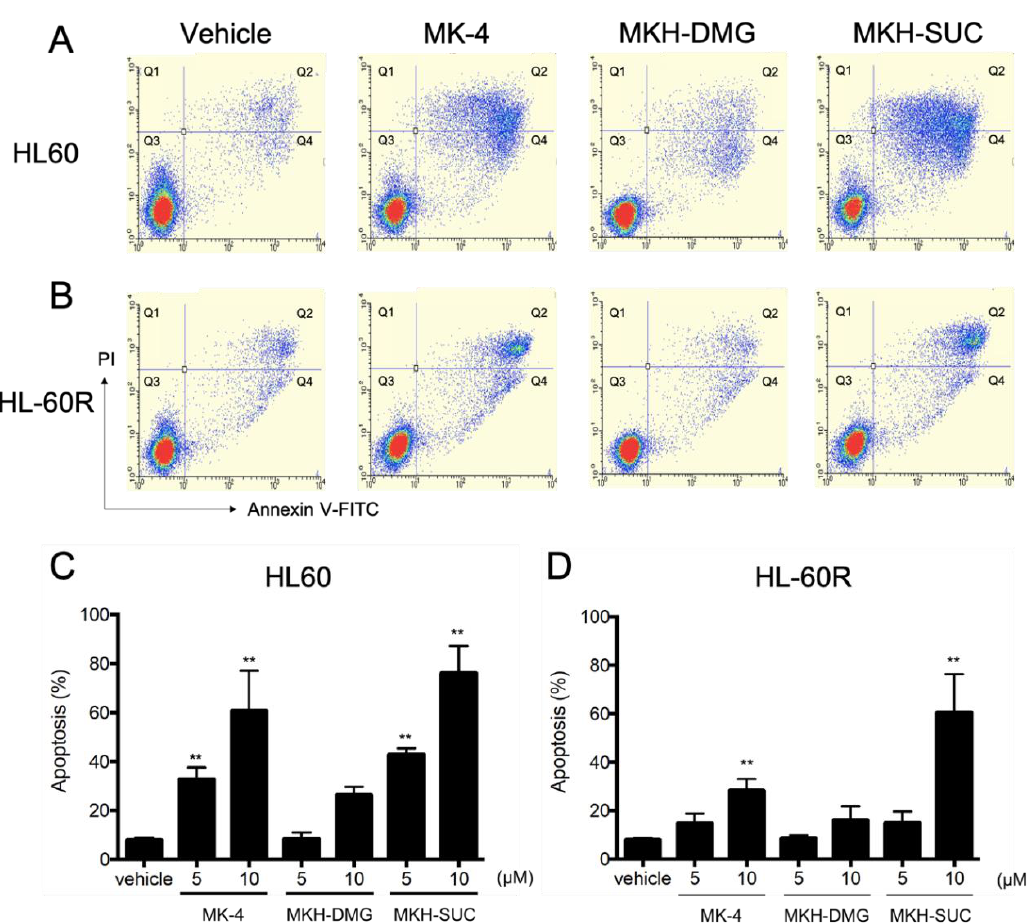
Figure 6. Effects of MK-4 and MKH derivatives on the apoptosis in HL60 and HL-60R cells. Typical flow cytograms of HL60 ( A ) and HL-60R ( B ) cells treated with the test drugs at 5 µM for 72 h are shown, with percentages of apoptotic HL60 ( C ) and HL-60R ( D ) cells treated with 5 or 10 μM MK-4, MKH-DMG, or MKH-SUC for 72 h. Apoptotic cells were determined using flow cytometry after Annexin V/PI staining. Data are shown as mean ± SD from triplicate experiments. ** p < 0.01 vs. vehicle by Dunnett’s test.